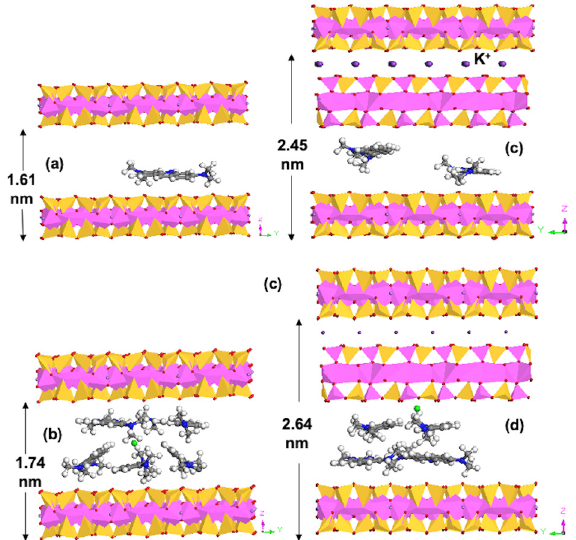
Figure 12. Molecular dynamics simulation showing AO intercalation in the interlayer of MT ( a , b ) and RT ( c , d ) under monolayer ( a , c ) and bilayer ( b , d ) configurations. Zn: green.